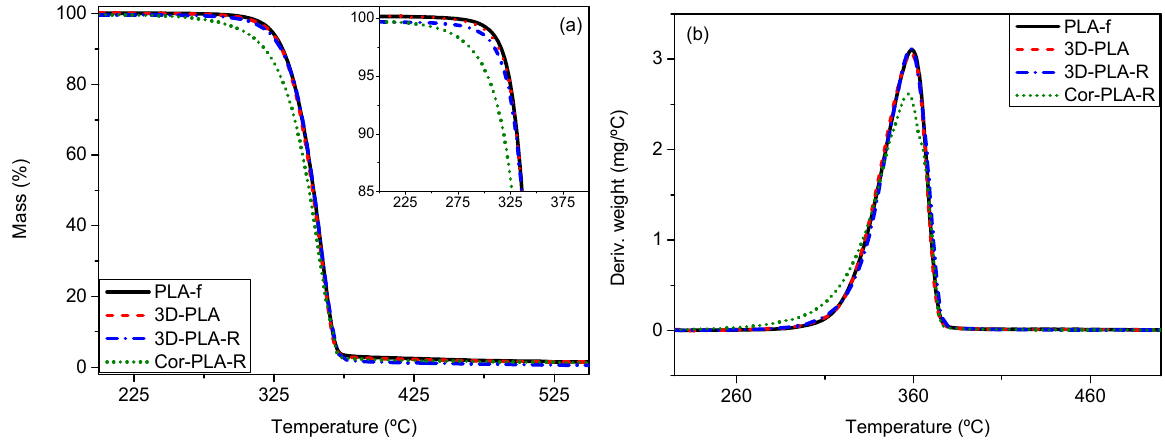
Figure 8. ( a ) TGA curves and ( b ) derivative thermogravimetric analysis (TGA) curves of the samples before and after mechanical recycling.